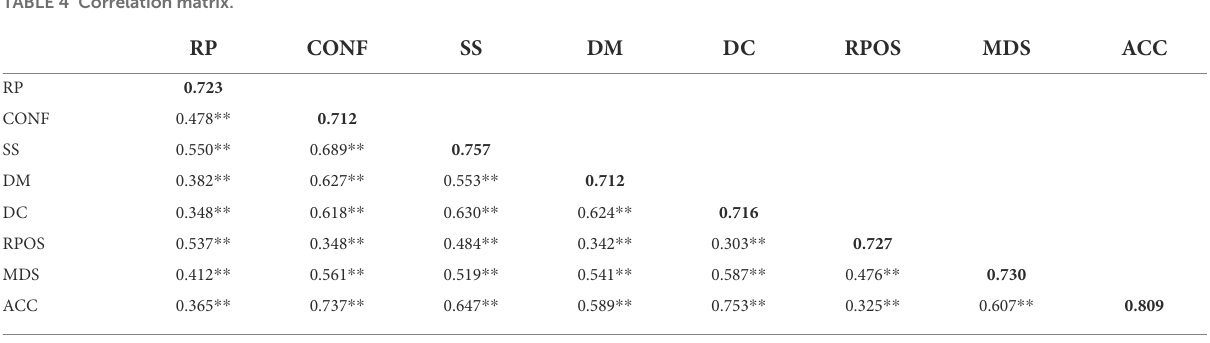
TABLE 4 Correlation